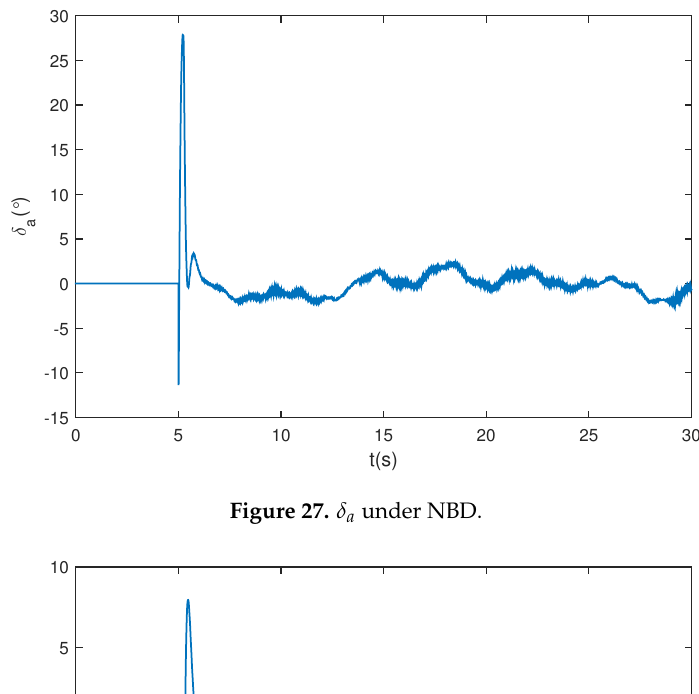
Figure 27. δ a under NBD.